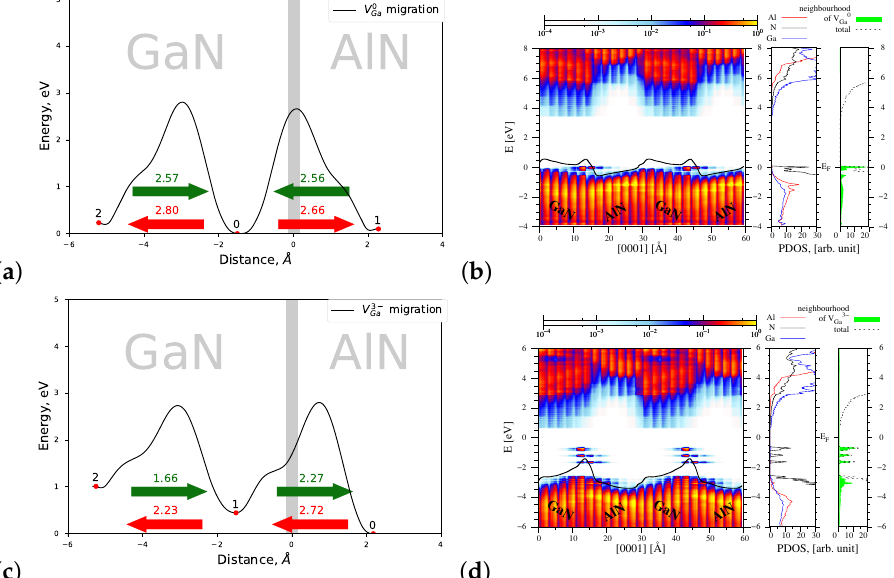
, the corresponding Al